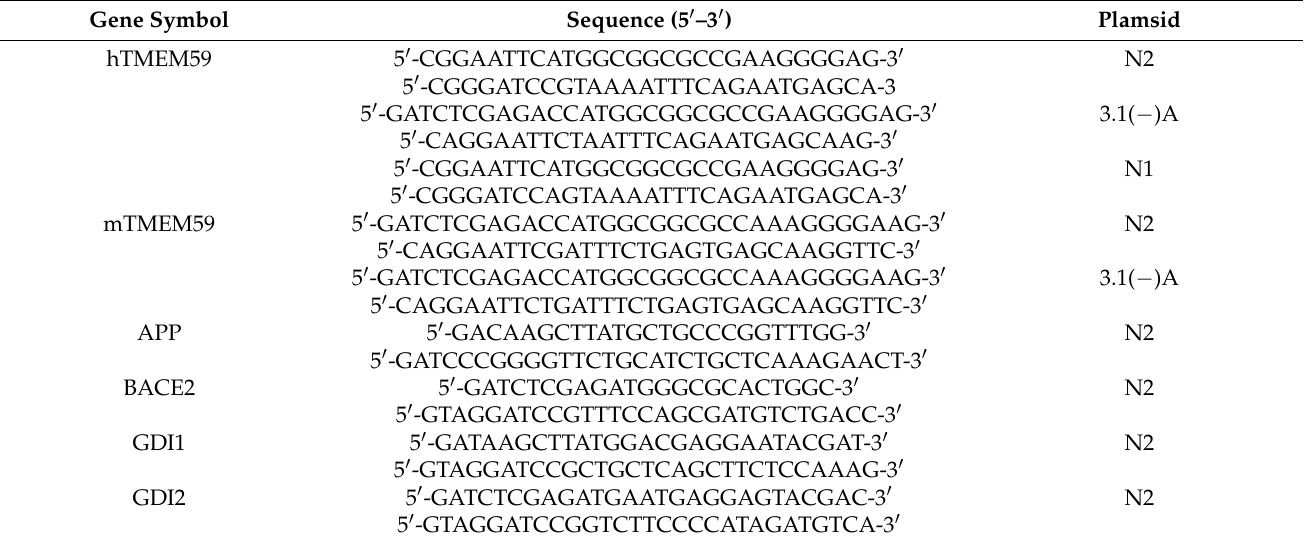
Table 1. Primer sequences of full-length genes used to construct